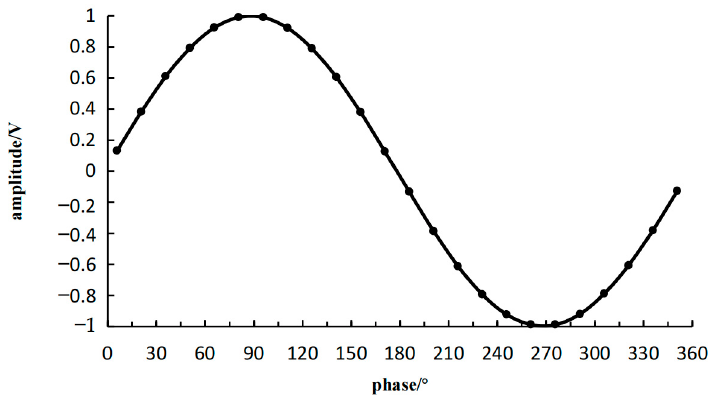
Figure 11. Measurement data and reconstructed waveform of 1 MHz sine signal.